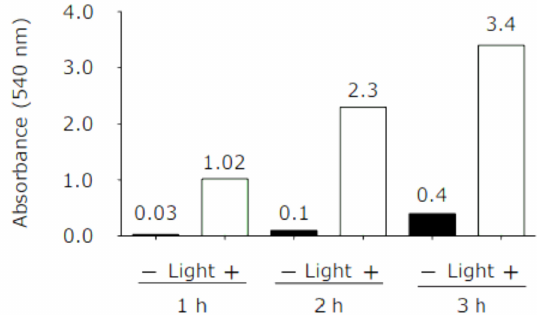
Figure 2. Light dependency of sodium nitroprusside (SNP) to degrade and release nitric oxide (NO). NO increased by time and the maximum release of NO in our study was observed from SNP under light after 3